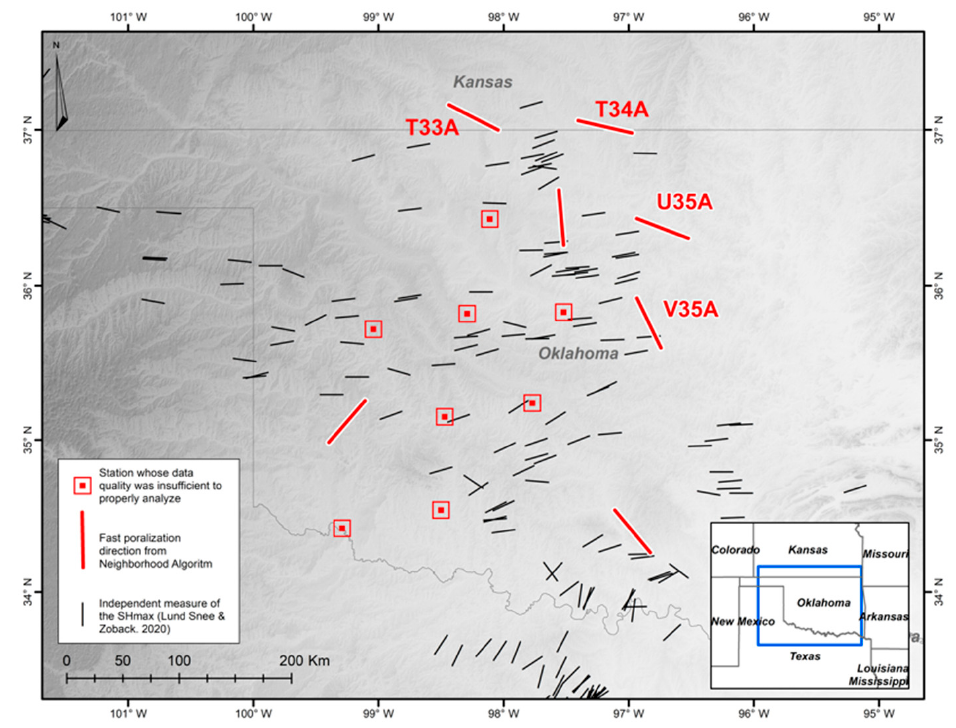
Figure 10. Map of the seven US Array stations analyzed in Oklahoma and Kansas (red symbols) and independent stress indicators (black symbols) [3,16].